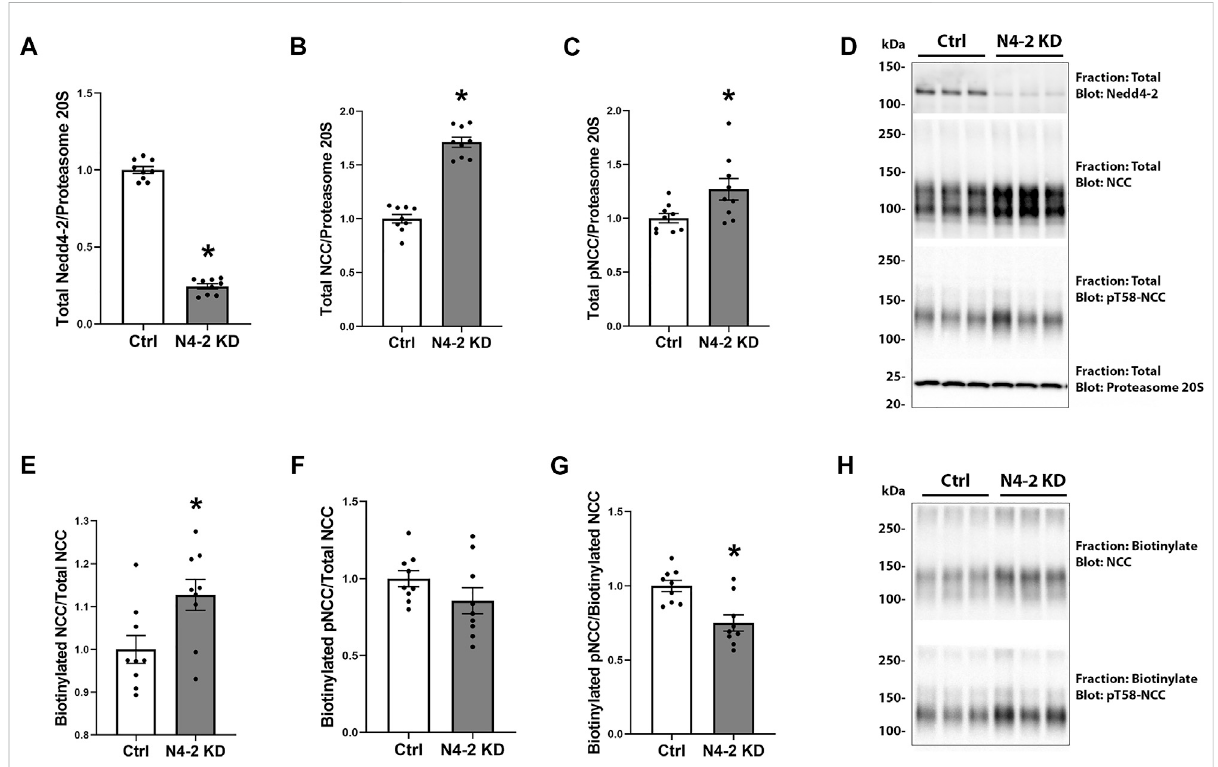
FIGURE 3 Nedd4-2de fi ciency increasestotalNCClevelsandplasmamembrane abundance.Semi-quantitativeassessmentofNedd4-2 (A) ,NCC (B) ,and pT58-NCC (C) levelsintotalcelllysatesofMDCKI-hNCCCtrlandNedd4-2(N4-2)KDcelllines.Dataaremeans±S.E.M.( n =9)* p < 0.05assessedby unpairedStudent ’ st-test. (D) RepresentativeblotsofNedd4-2,NCC,andpT58-NCCintotalcelllysatesofMDCKI-hNCCCtrlandN4-2KDcelllines. Semi-quantitative assessment of NCC (E) , pT58-NCC (F) and the NCC/pT58-NCC ratio (G) in membrane fractions of MDCKI-hNCC Ctrl and Nedd4-2 (N4-2) KD cell lines. Data are means ± S.E.M. ( n = 9) * p < 0.05 assessed by unpaired Student ’ s t-test. (H) Representative blots of NCC and pT58-NCC in membrane fractions of MDCKI-hNCC Ctrl and N4-2 KD cell